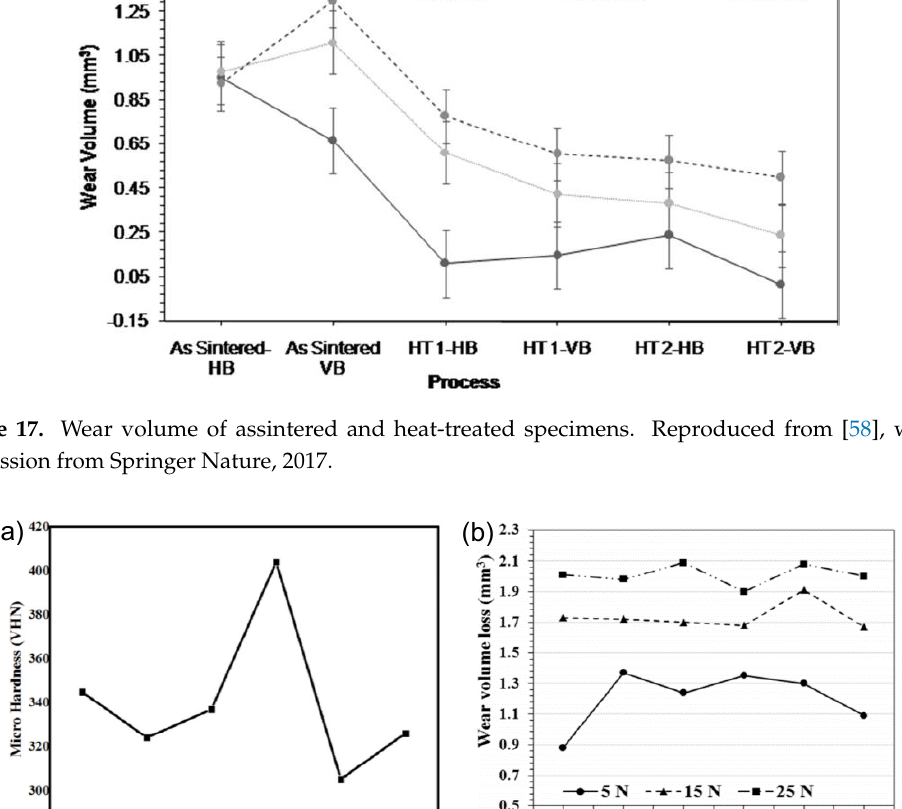
Figure 16. Microstructures of ( a ) sintered VB, ( b ) HT 1-VB and ( c ) HT 2-VB. Reproduced from [58], with permission from Springer Nature, 2017.